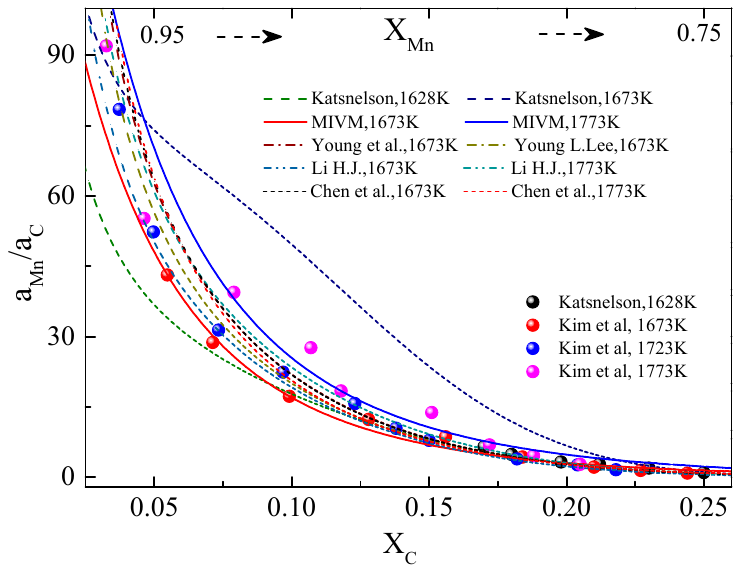
Figure 2. The calculated activity of Mn/C in Mn–C melt at 1673 K and 1773 K compared with experimental data. Table 2. Calculated values of B MnC and B CMn using MIVM in Mn–C binary liquid alloys at 1628 K to 1773 K.